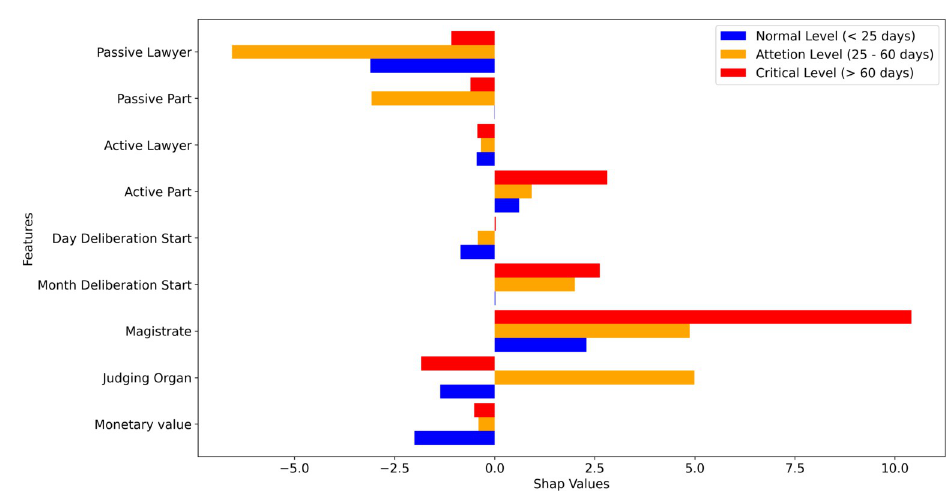
Fig 4. The contribution of each feature for the increase or decrease of the prediction target by alert level.